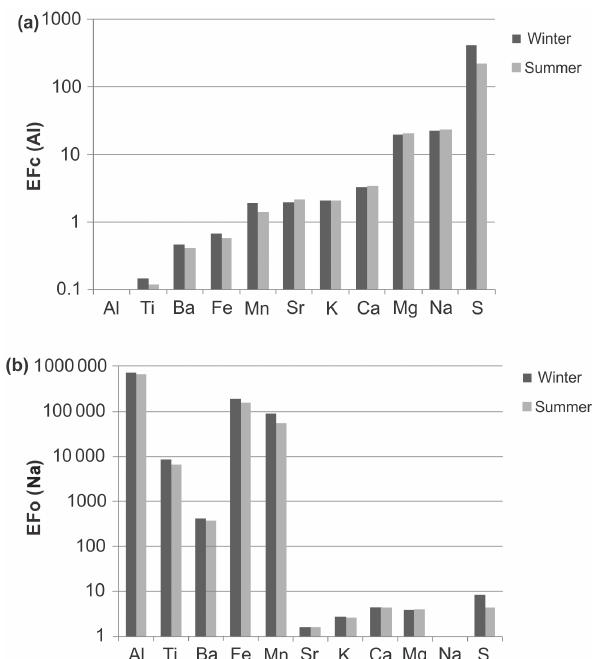
Figure 2. (a) Mean element enrichment factors in reference to Earth’s crust (EFc) and (b) oceanic composition (EFo) at the MJ site for austral summer (December–February) and austral winter (June–